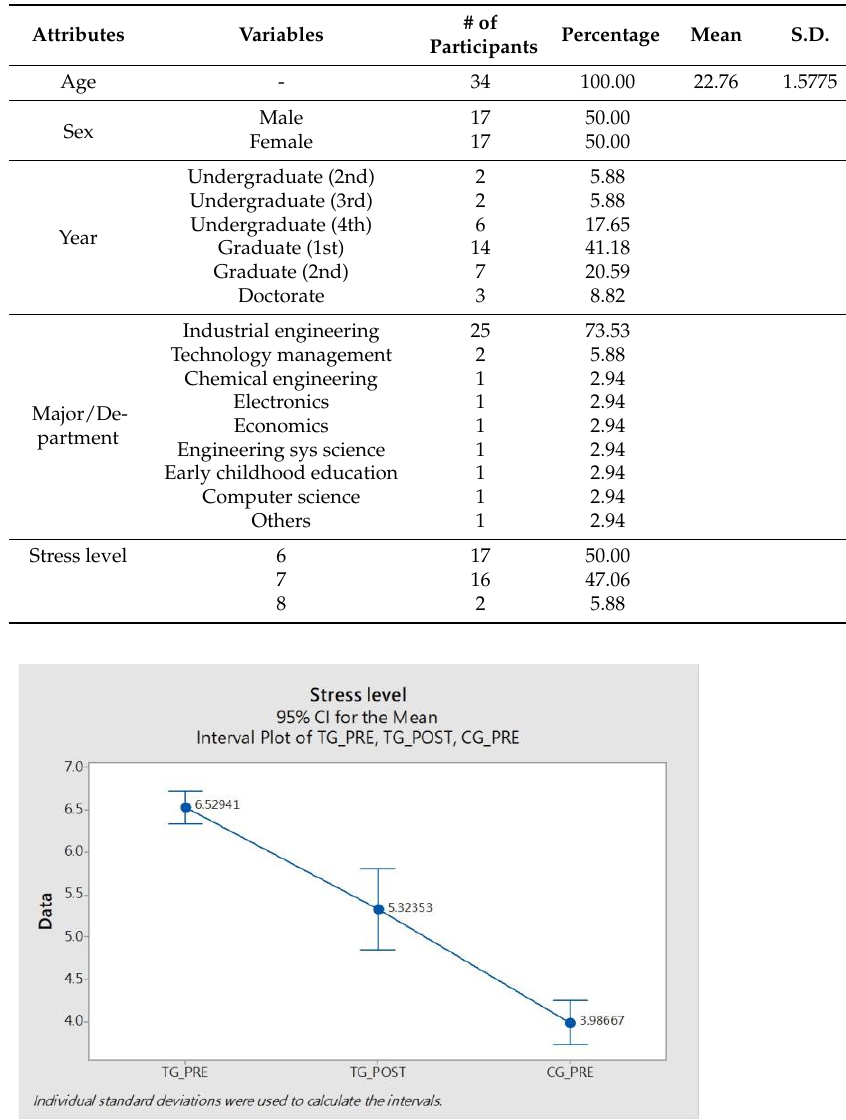
Figure 12. Interval plot for Life impact of TG_PRE, TG_POST, and CG. According to the questionnaire design, Life impact can be further divided into Be- havioral impact, Physical impact, Cognitive change, and “ Social mode change ” . The re- spective interval plots are shown in Figure 13. ( a ) Behavioral impact